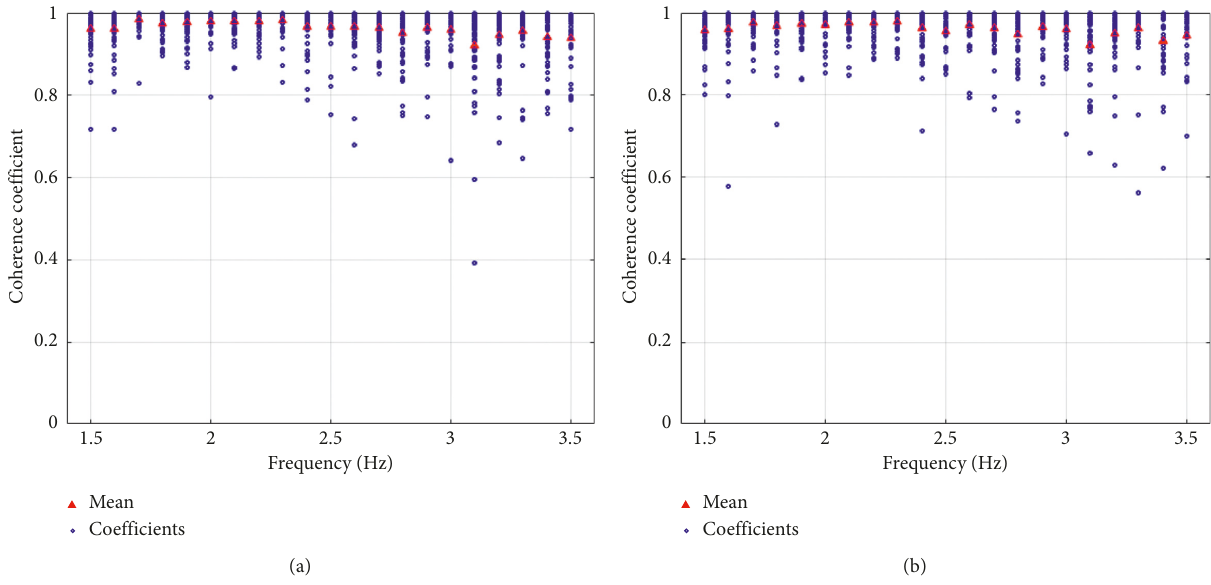
Figure 21: Coherence coefficients of all cases along with metronome frequency at two frontal distances of (a) 1m and (b) 2m.